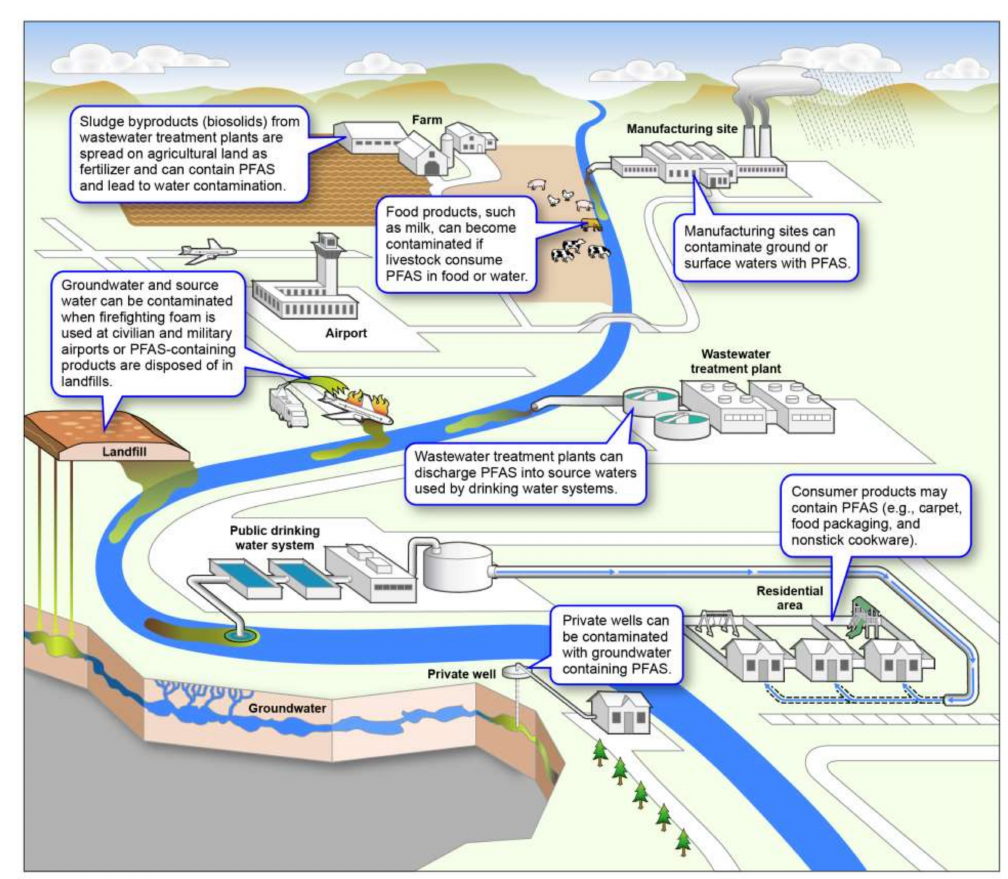
Figure 2. Overview of common pathways through which PFAS enter the environment. Originally published by the Government Accountability Office in report GAO-21-37: ‘Man-Made Chemicals and Potential Health Risks, EPA Has Completed Some Regulatory-Related Actions for